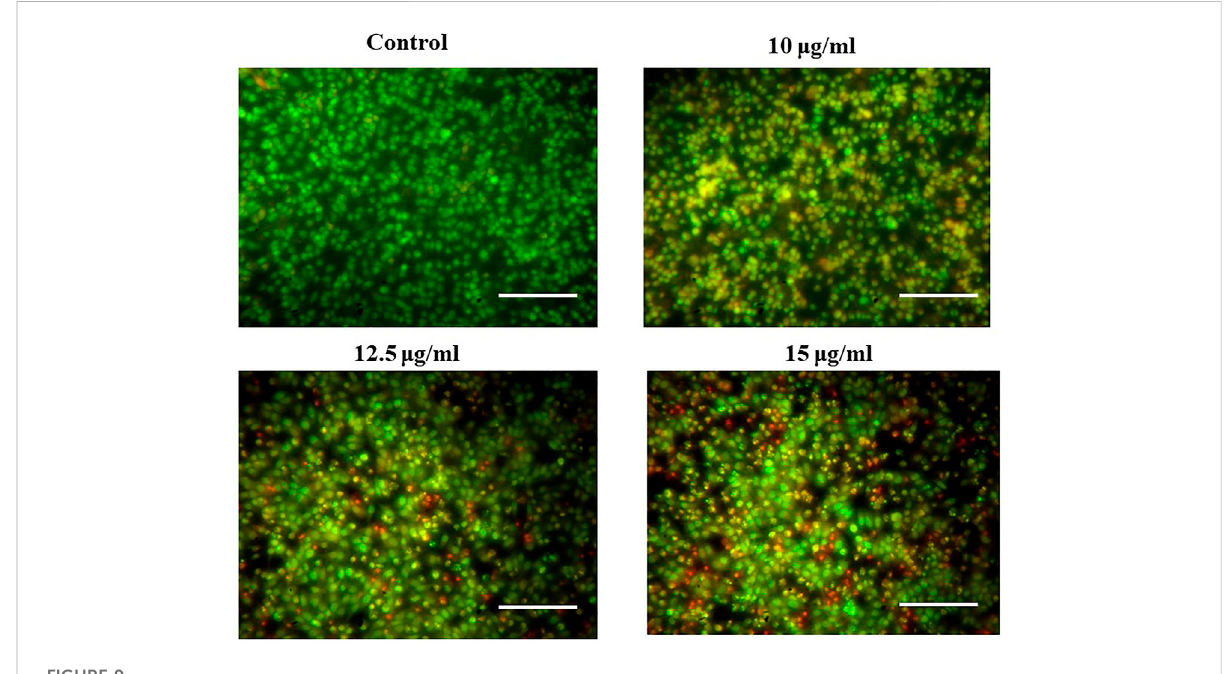
FIGURE 9 Treatment of MgONPs resulted in induction of